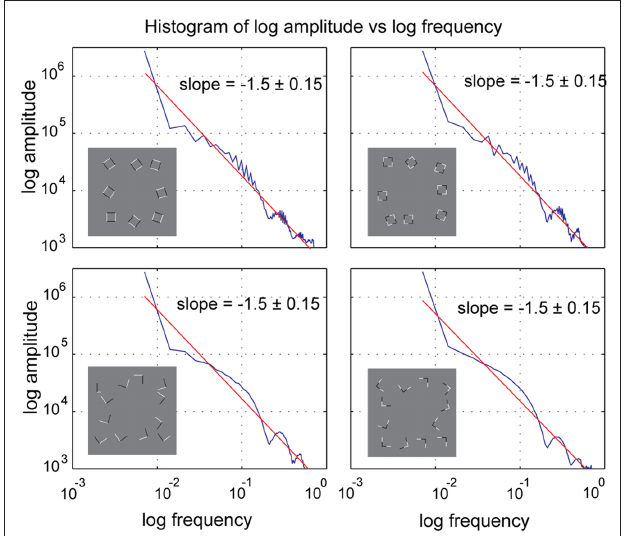
FIguRE 6 | Amplitude histogram of rotationally averaged power spectrum analysis. There are small differences between spectra of the same within geometrical configurations (i.e., between the two square conditions), but these differences are subtle and most importantly the slopes and the area under the curves is very similar across